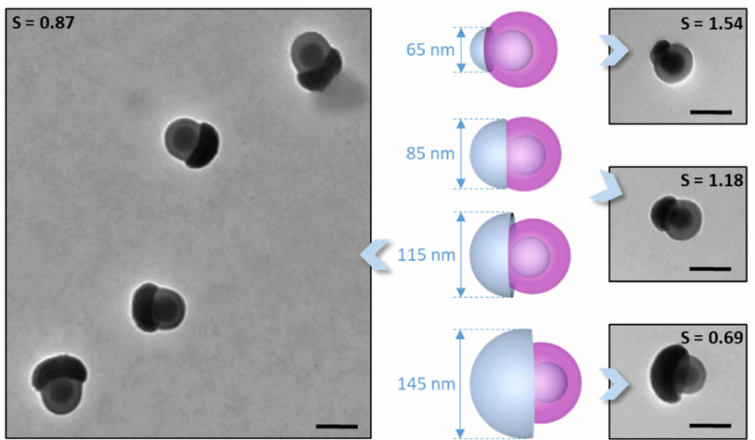
Figure 2. Representative TEM image of silica nanoparticles of sizes from 65 to 145 nm with a single PS patch of which the diameter was 100 nm. As a consequence, the patch-to-particle size ratio S values of these particles varied from 1.54 to 0.69. Scale bars: 100 nm. Due to their higher electron density, silica particles had a significantly more contrast and therefore appeared darker than PS ones of a similar size. A low-magnification image of the one-patch silica nanoparticles with S = 0.69 is displayed in Figure